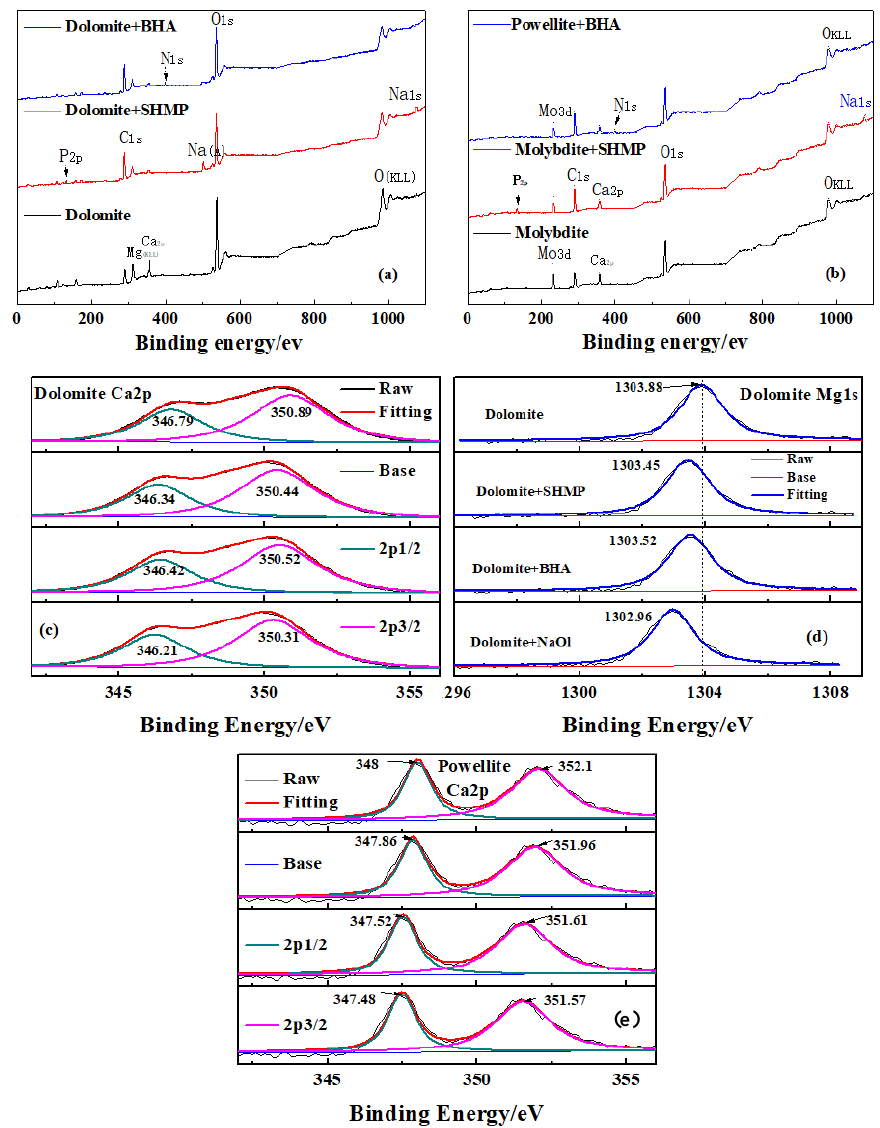
Figure 7. ( a ) XPS spectra of dolomite surface and ( b ) powellite surface; ( c ) XPS fine scanning spectra of ( c ) Ca and ( d ) Mg on dolomite; and ( e ) XPS fine scanning spectra of Ca on powellite.